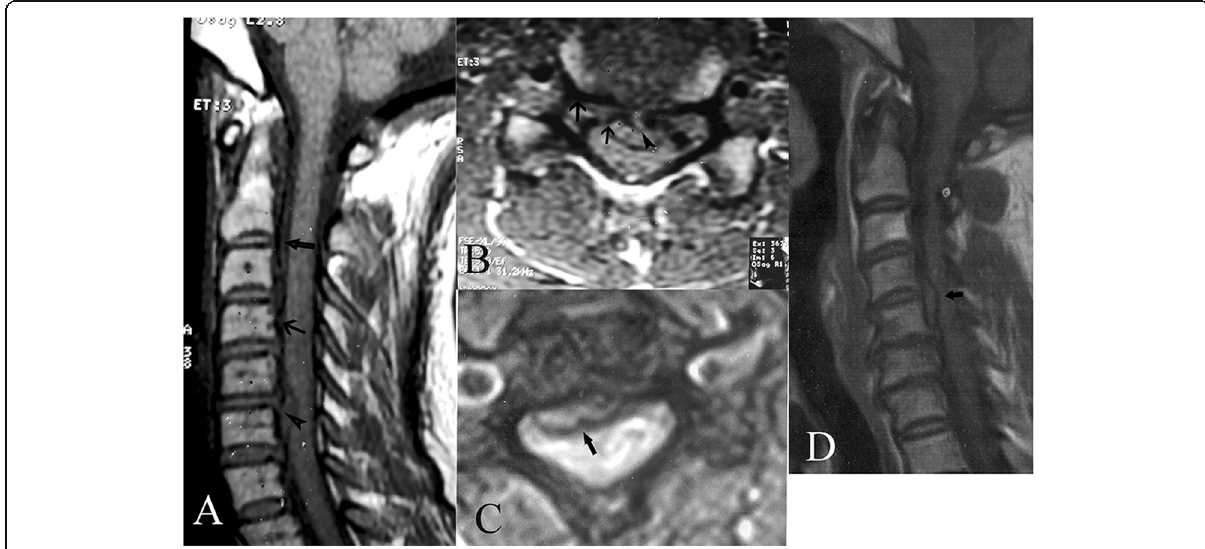
Fig. 1 a , b Sagittal and axial T1 MRI cervical spine. Arrows point to an intact PLL. The arrowhead points to the site of PLL interruption through which the disk material herniates. c , d Axial and sagittal MRI cervical spine; black arrows point to an intact